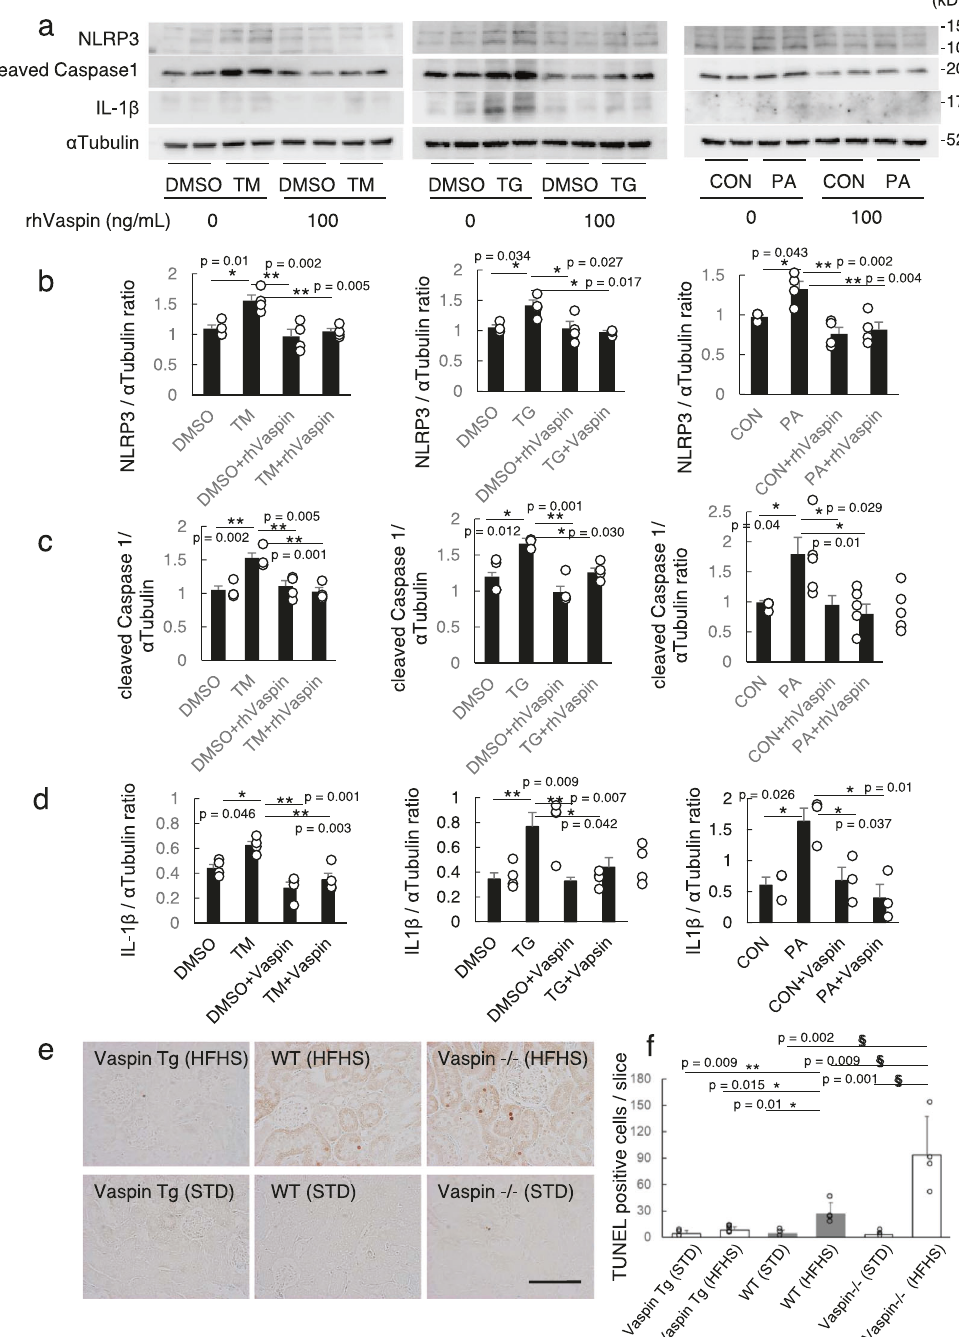
Fig. 4 Inhibition of NLRP3 in fl ammasome activation by recombinant human vaspin (rhVaspin). HK2 cells were cultured with DMSO or 1 μ g/ml tunicamycin (TM) or 1 μ M thapsigargin (TG) or 500 μ M Palmitate (PA) for 24 h. rhVaspin was co-administrated at 100 ng/ml for 24 h. a . Western blot analysis of NLRP3 infammasome pathway related proteins; NLRP3, Caspase 1 and IL-1 β . b – d . Densinometric quanti fi cation of Western blots. NLRP3 ( b ), cleaved Caspase 1( c ), and IL-1 β ( d ) are normalized by α Tubulin. Data are shown as means ± S.E., n = 4 – 5 independent experiments, * p < 0.05, ** p < 0.01. e . TUNEL staining. Bar = 100 μ m. f Number of TUNEL-positive tubular cells per one slice are counted, then analyzed with one-way ANOVA followed by Tukey-Kramer method, n = 3 – 5 independent mice. Data are presented as mean ± S.D.* p < 0.05, ** p < 0.01 in comparison of Vaspin Tg and WT mice